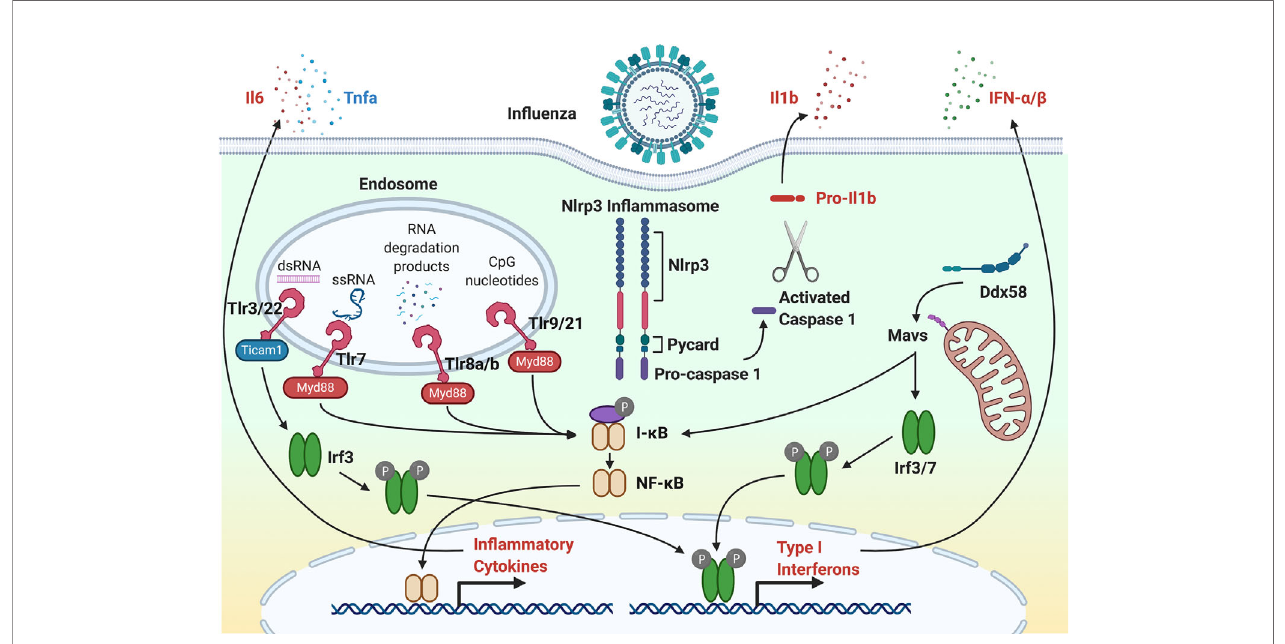
FIGURE 1 | The antiviral response to In fl uenza A Virus infection. Following IAV entry and infection, single-stranded RNA (ssRNA) and RNA degradation products incorporated into endosomes are recognized by Tlr7 and Tlr8a/b, respectively. In other virus infections, double-stranded RNA by Tlr3 and Tlr22. CpG motifs are recognized and Tlr9 and Tlr21. For Tlr7, Tlr8a/b and Tlr9, the TLR-adaptor, Myd88, activates the NF- k B transcription factor through IkB. NF- k B initiates transcription of in fl ammatory cytokines, such as Il6, Il1b, and Tnfa. For Tlr3, the TLR-adapter, Ticam1, activates Irf3 that initiates transcription of type I interferons. DAMPs and PAMPs can activate the Nlrp3 in fl ammasome through activated caspase 1. Activation of RIG-I (Ddx58) by cytosolic viral RNA activates Irf3 and Irf7 transcription factors through Mavs. Irf3 and Irf7 initiate the expression of type 1 interferons that further exacerbates the antiviral innate immune response to